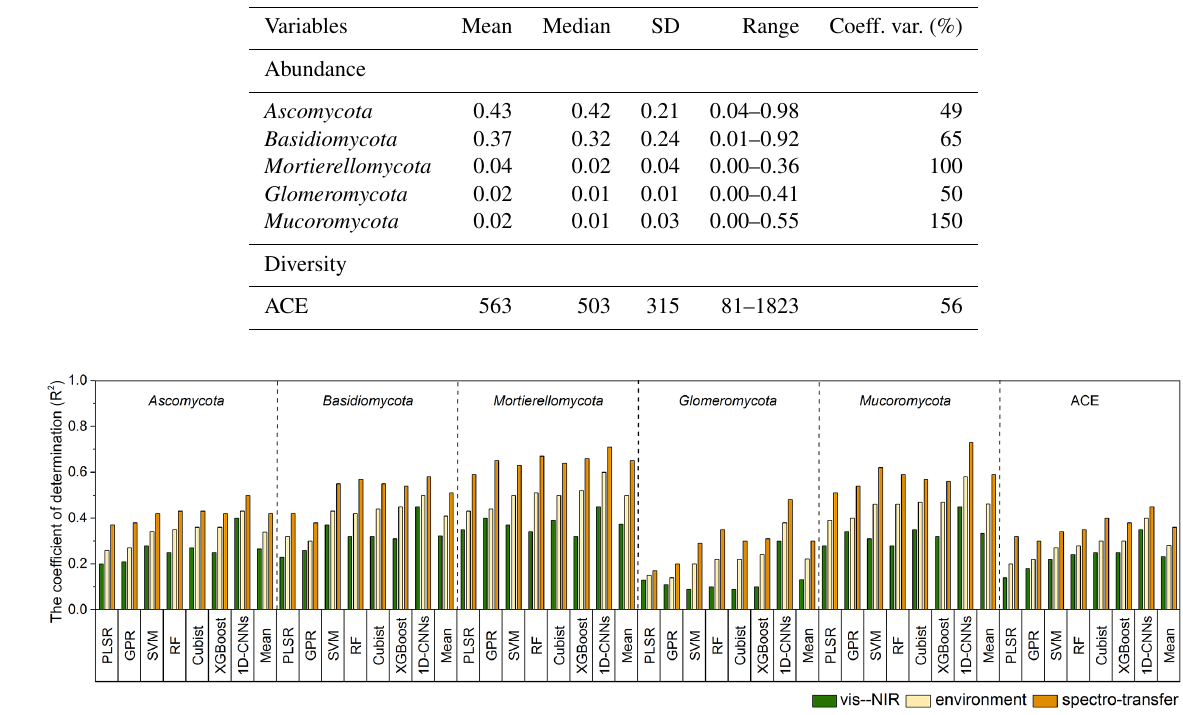
Table 1. Descriptive statistics of relative abundance of dominant phyla and community diversity ( n = 577).